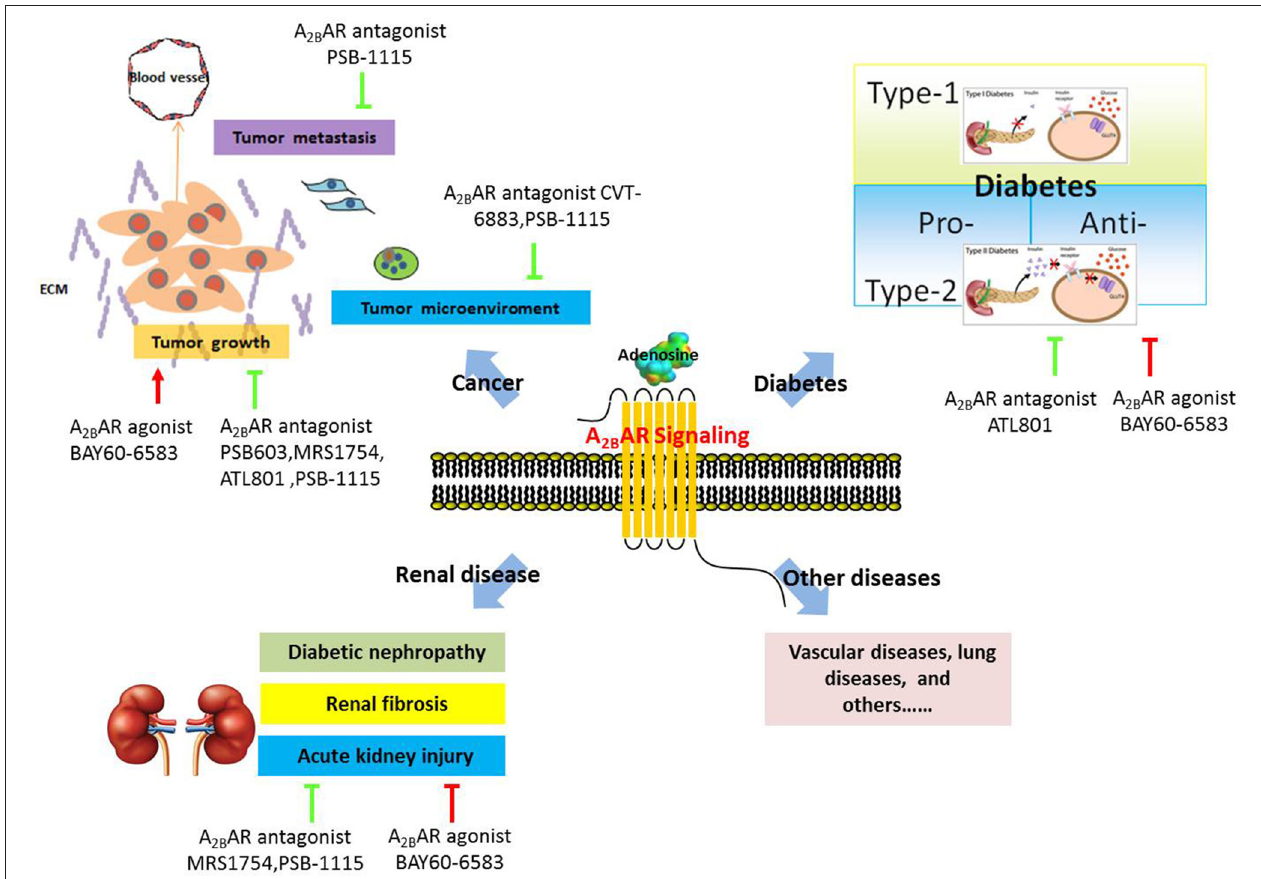
FIGURE 2 | Schematic presentation of the role of A 2B AR in various human diseases.